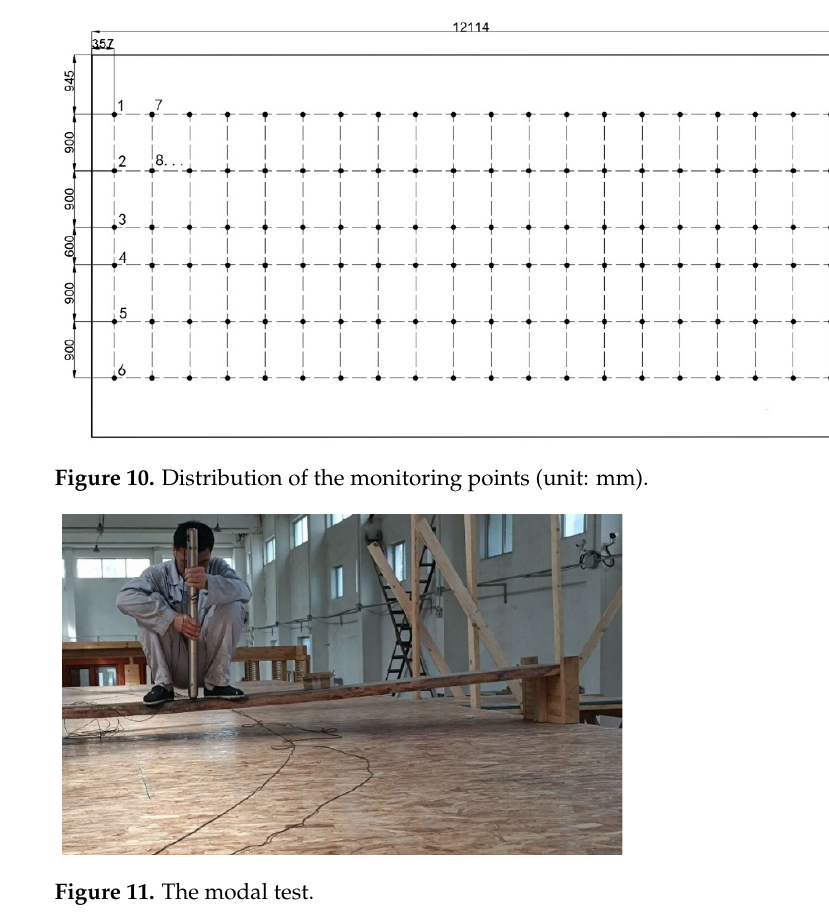
Figure 11. The modal test.